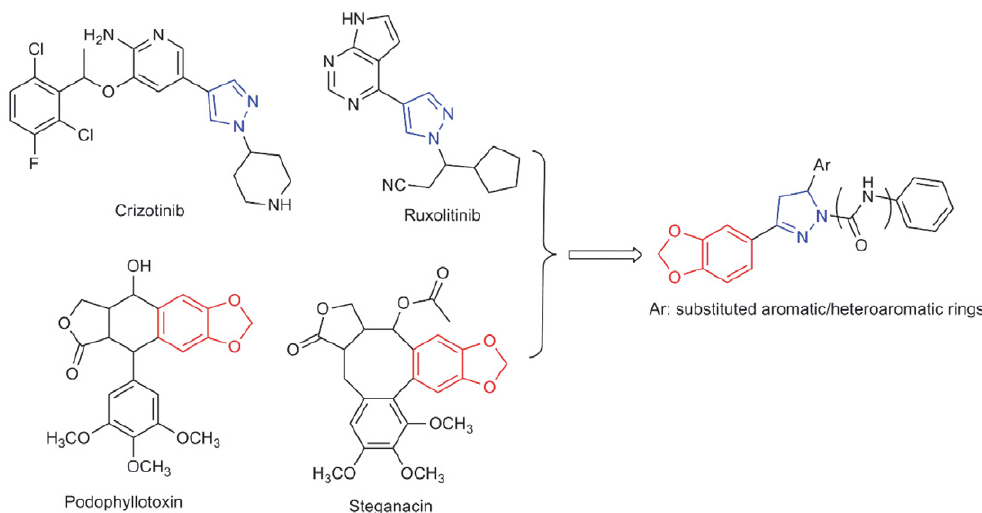
Figure 1 . Design strategy of the target